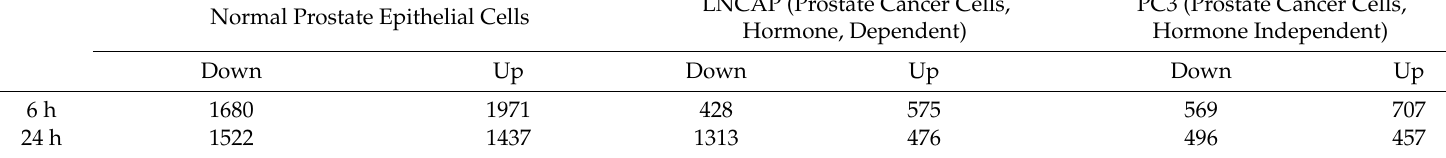
b. Summary of Results from Human Prostate Cancer Cells Data